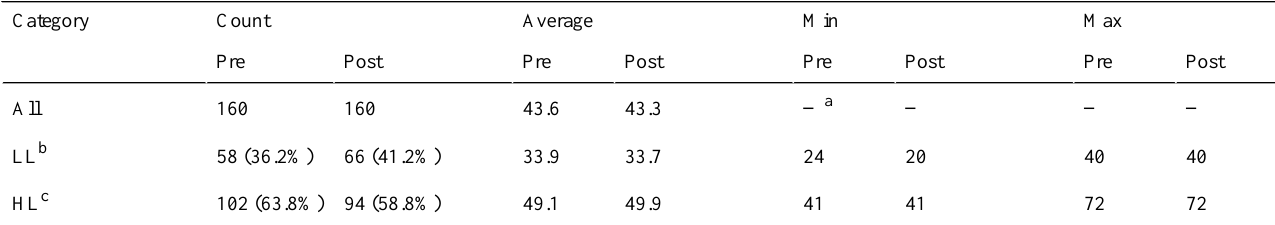
Table 2. Statistics of high and low loneliness scores measured by University of California, Los Angeles, scale in pre- and postsurveys. MaxMinAverageCountCategory